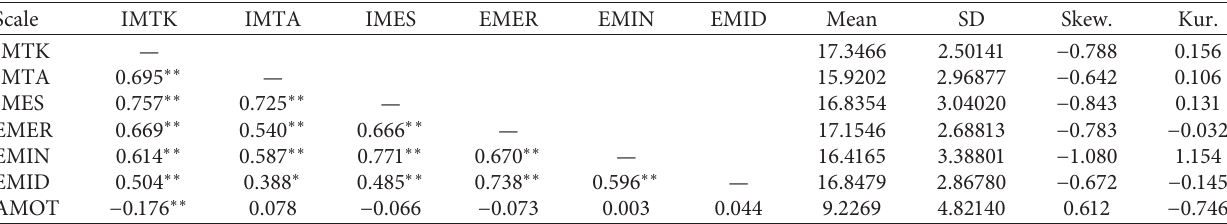
Table 2: Descriptive